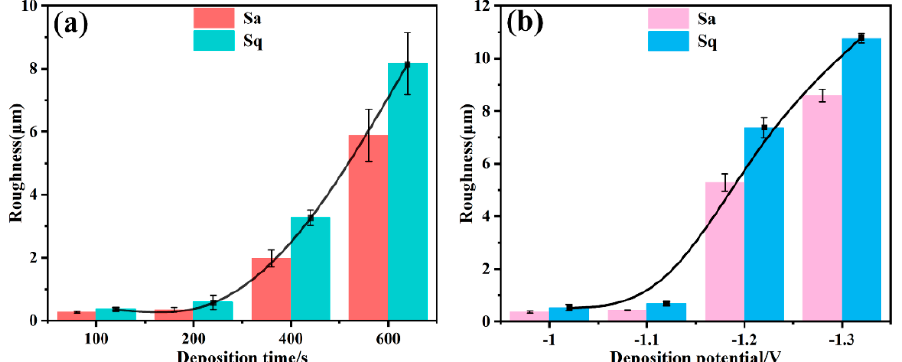
Figure 10. Surface roughness Sa and Sq values of the coatings versus ( a ) deposition time and ( b ) deposition potential.